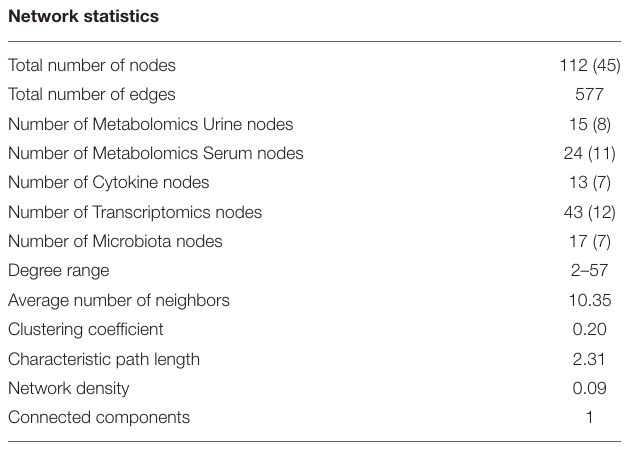
TABLE 3 | Characteristics of the merged network.